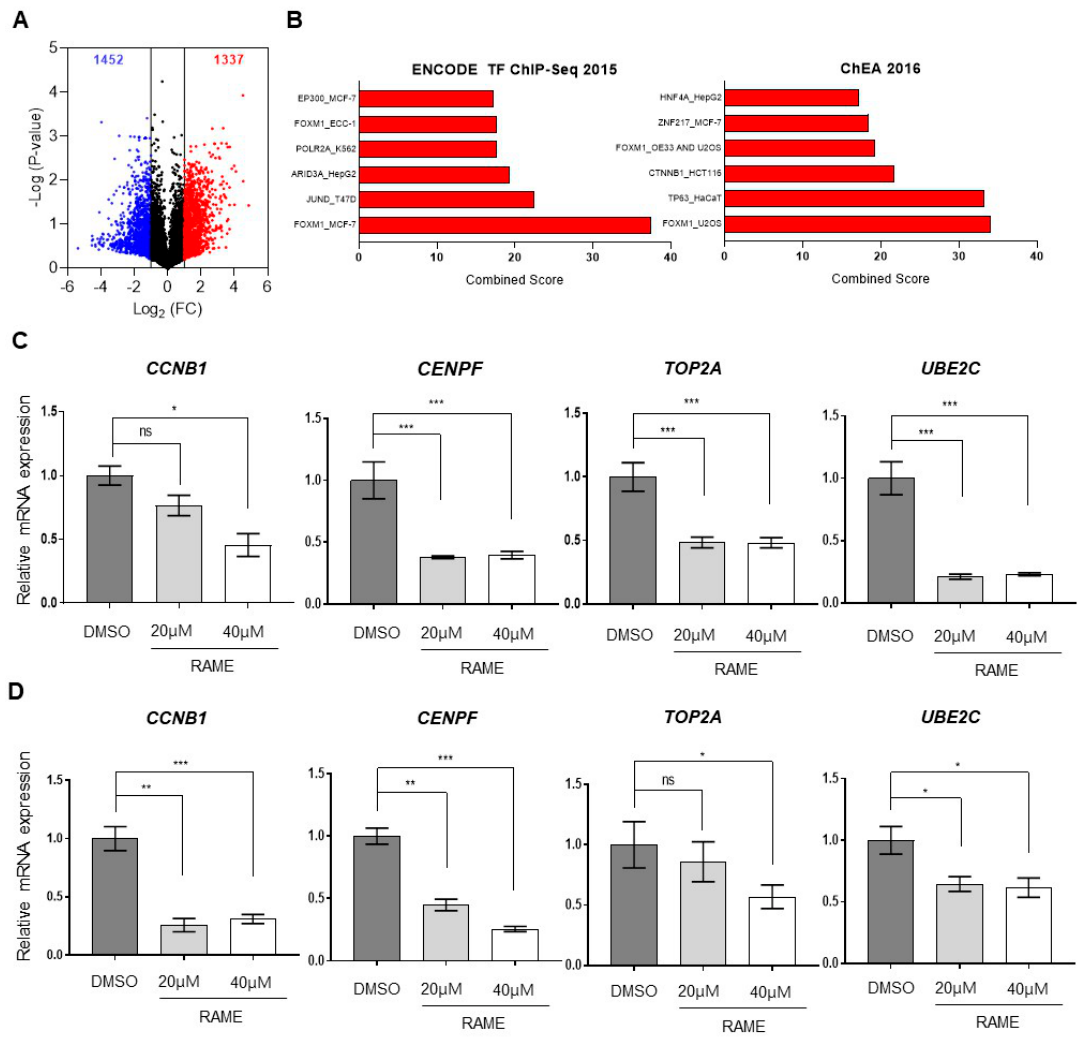
Figure 1. Transcriptome analysis of SKOV-3 cells treated with RAME shows that FOXM1 target genes are downregulated. ( A ) RNA-sequencing data with RAME (40 µ M)-treated SKOV-3 ovarian cancer cells. ( B ) Gene Ontology (GO) analysis of RNA-sequencing data using the Enrichr tool. ( C ) The mRNA expression levels of FOXM1 target genes in SKOV-3 cells treated with RAME (20 µ M and 40 µ M) for 24 h. ( D ) The mRNA expression levels of FOXM1 target genes in TOV-21G cells treated with RAME (20 µ M and 40 µ M) for 24 h. Error bars correspond to mean ± SEM ( n = 3). * p < 0.05, ** p < 0.01, *** p < 0.001; unpaired t -test.